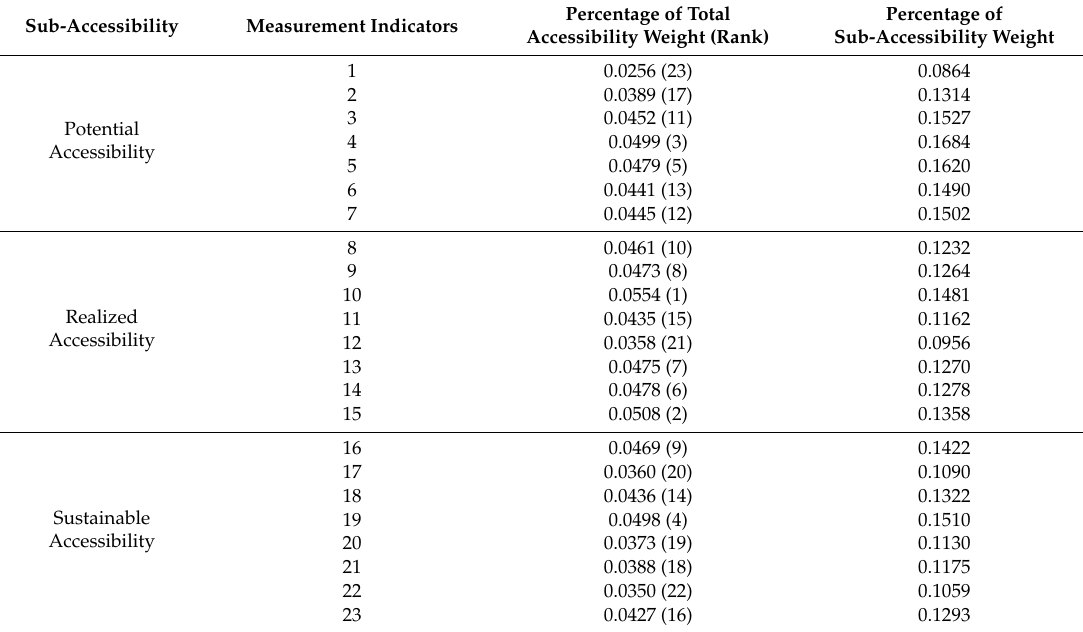
Table 8. Weight of indicator of accessibility of healthcare services for the